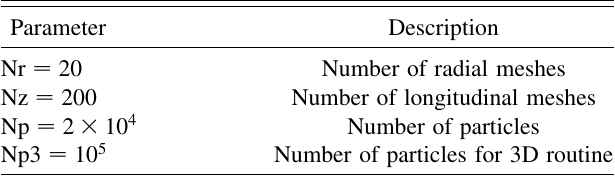
TABLE I. Parameters used in PARMELA simulation.